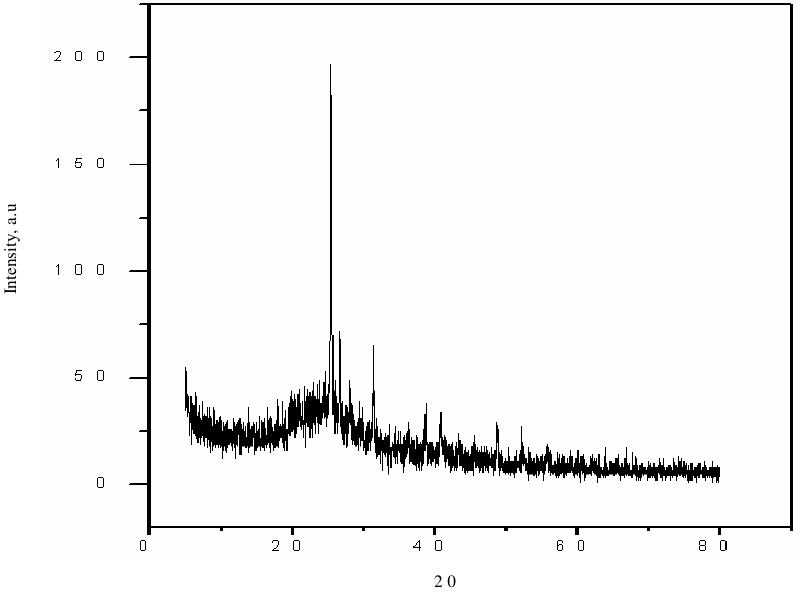
Figure 8. XRD Pattern of Enteromorpha